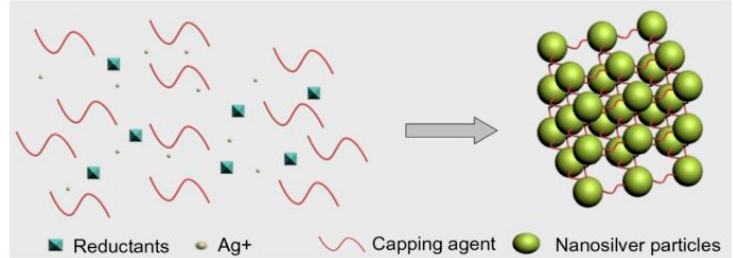
Figure 3. Chemical synthesis of Ag NPs. Reproduced with permission from Dovepress, 2014 [105].